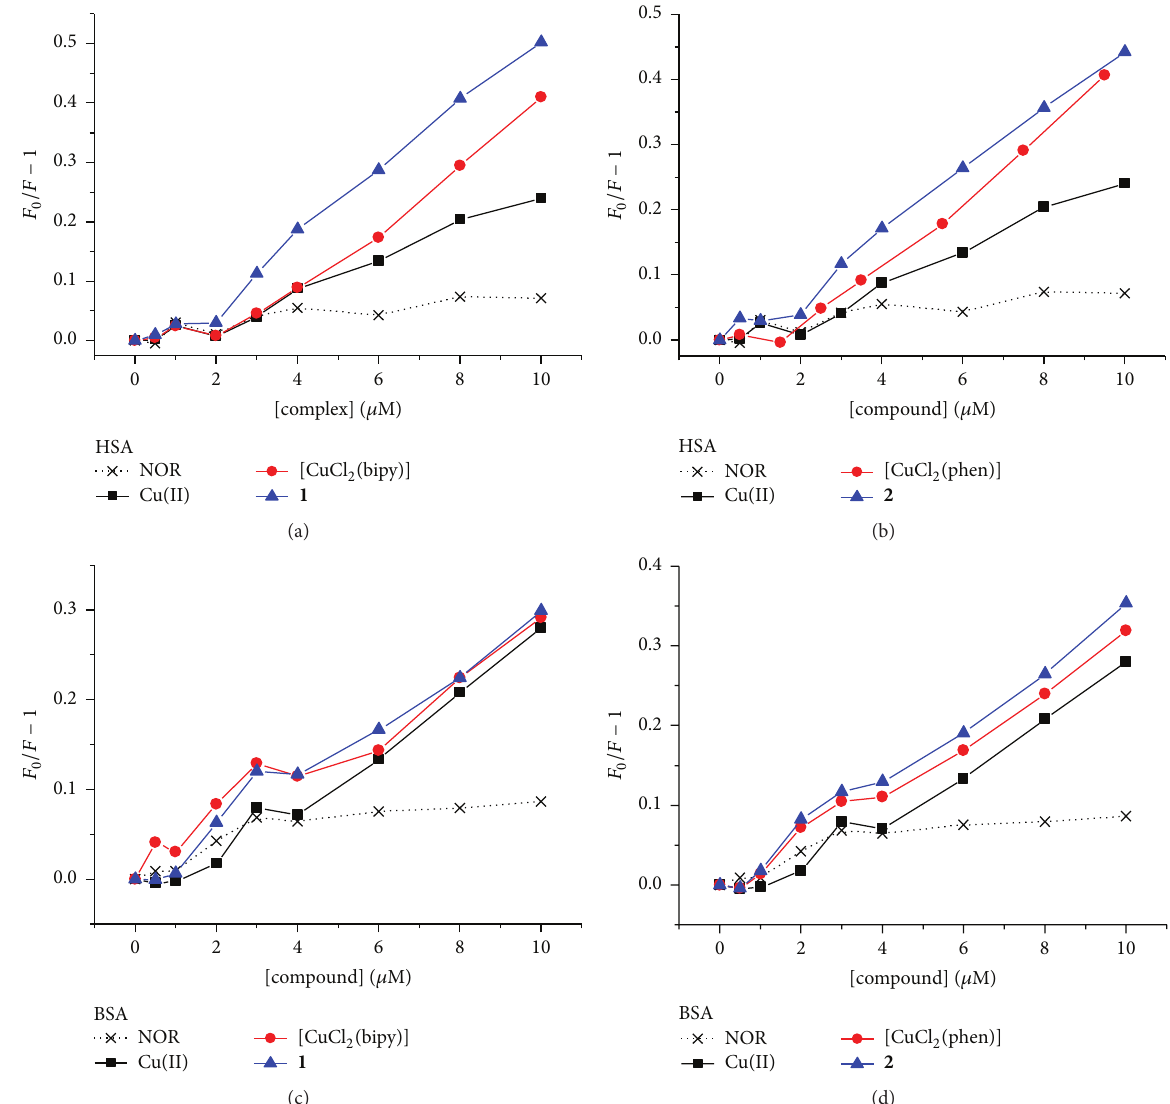
Figure 5: Stern-Volmer plots for the quenching of albumins’ intrinsic fluorescence by the copper complexes: (a) HSA-complex ( 1 ), (b) HSA- complex ( 2 ), (c) BSA-complex ( 1 ), and (d) BSA-complex ( 2 ). Control results of the effects of NOR and Cu(II) are also presented. 𝐹 0 and 𝐹 are the fluorescence intensities at the peak in the absence and presence of the complexes. HSA and BSA concentrations equal to 4.0 × 10 −6 molL −1 ; temperature: 296